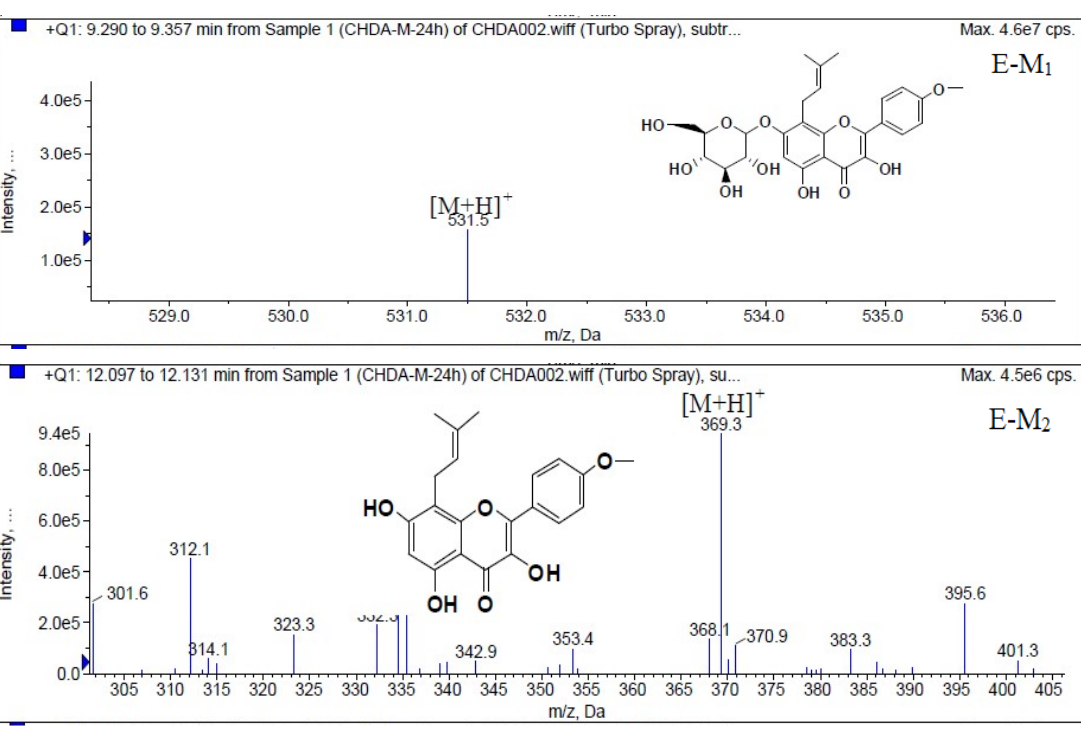
Figure 7. Mass spectra of metabolite of epimedin A. E for metabolites in intestinal enzyme; F for metabolites in intestinal